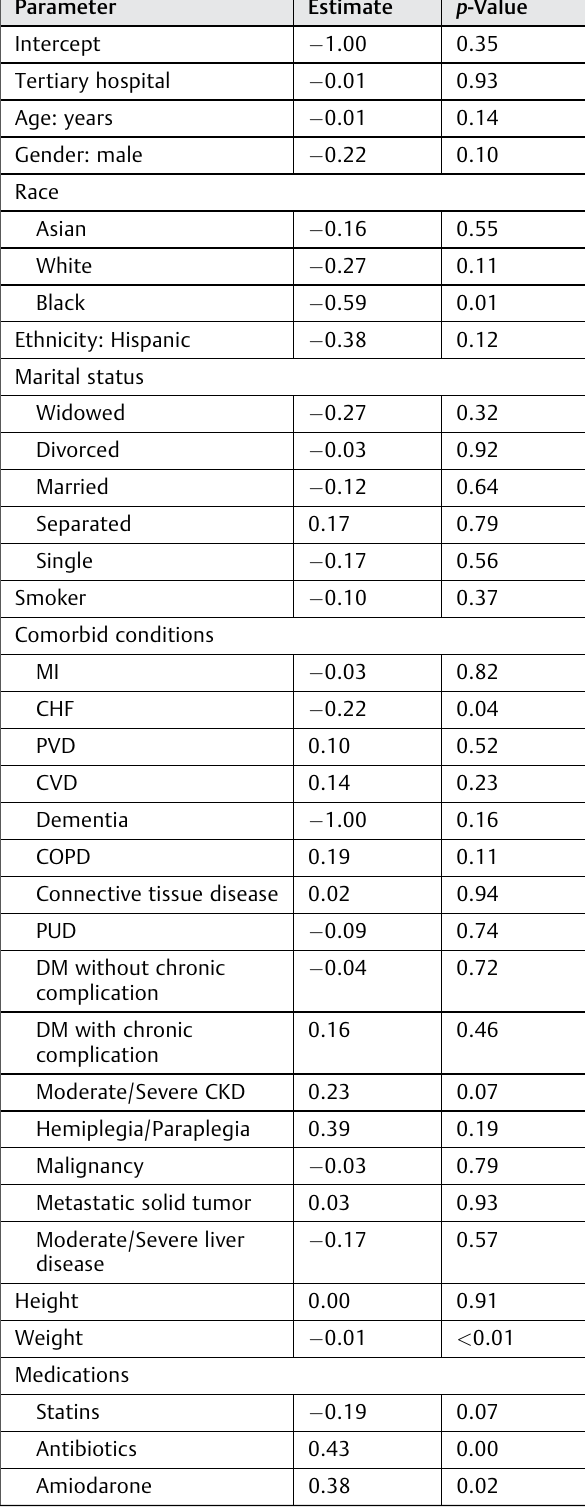
Table 4 Prediction model for INR overshoots: analysis of maximum likelihood estimates Parameter